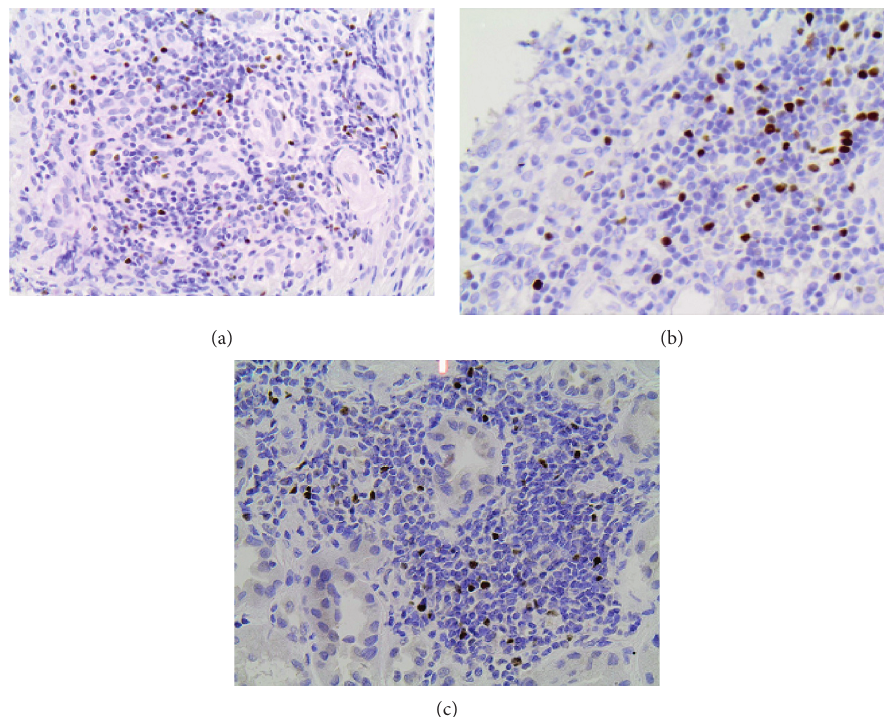
Figure 3: Immunohistochemical stain of FOXP3+ regulatory T cells (Tregs) in interstitial inflammatory cell infiltrates in: (a) IgA ne- phropathy (IgAN), (b) focal segmental glomerulosclerosis (FSGS), and (c) membranous glomerulopathy (MGN). Cells stained dark brown are considered positively stained FOXP3+ Tregs, and blue-stained cells are negatively stained